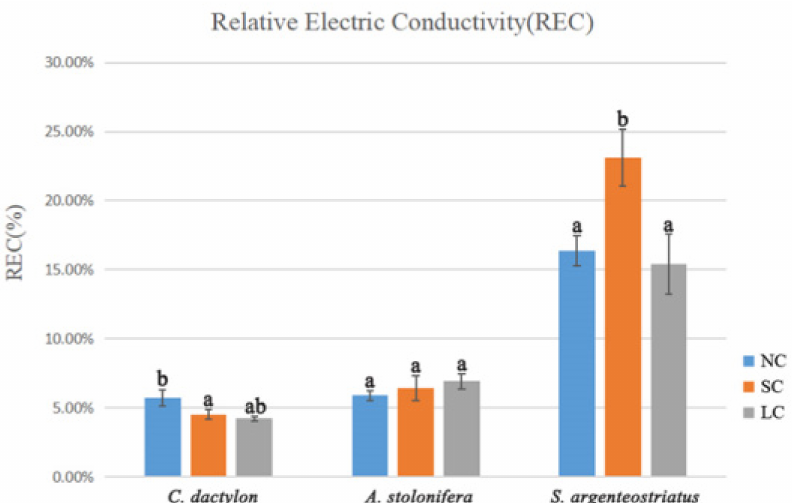
Figure 11. Graph of relative electrical conductivity. Note: Different normal letters indicate significant differences among treatments ( p <